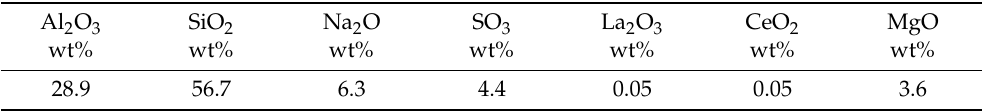
Table 2. Chemical composition (wt%) analysis table for each component of pretreated silica-rich waste powder with diluted rare earth oxides